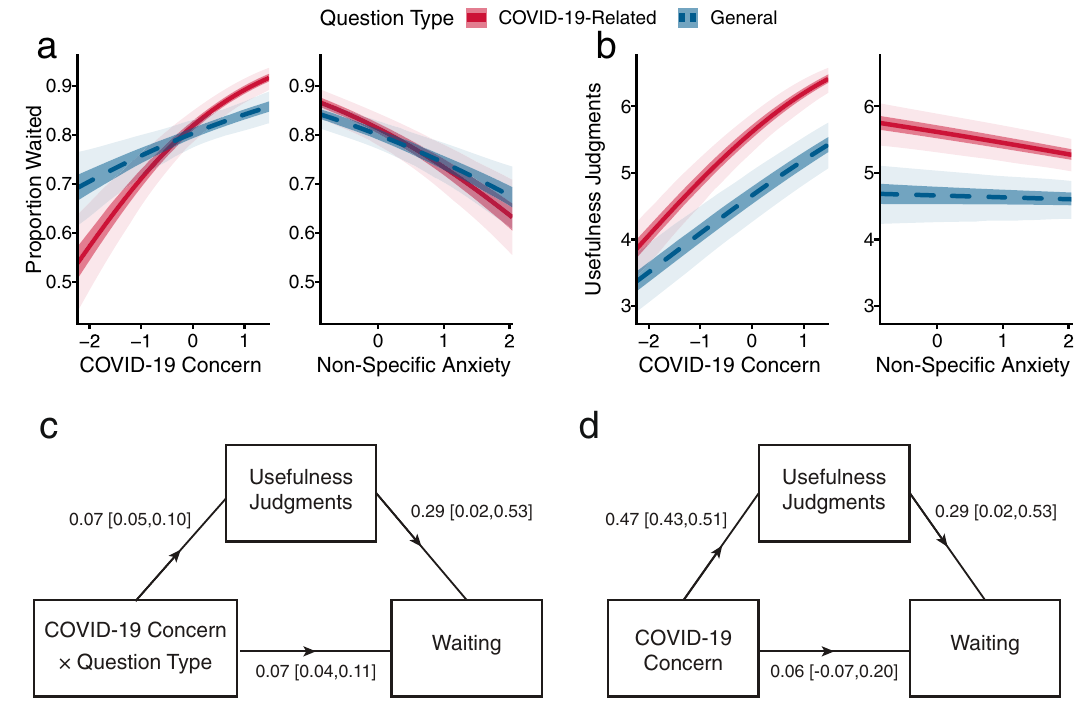
Fig. 2 Motivation is associated with a directed and energized pattern of information-seeking. a Higher COVID-19 concern is associated with more waiting for COVID-19-related questions, relative to general questions. It is also associated with more waiting for general questions (left panel). Non- speci fi c anxiety, on the other hand, negatively predicts waiting for all questions (right). b Participants reporting higher COVID-19 concern judge questions as more useful, especially COVID-19-related questions (left panel). Participants reporting higher levels of non-speci fi c anxiety tend to judge questions as less useful, especially COVID-19-related questions (right). a , b Lines denote mean posterior prediction; dark shaded areas mark 50% PIs, and light areas 95% PIs. c Data are consistent with our hypothesis that the directing effect of COVID-19 concern on information-seeking should be mediated via expectations of utility. We fi nd a signi fi cant indirect effect of the interaction between COVID-19 concern and question type on waiting, mediated by